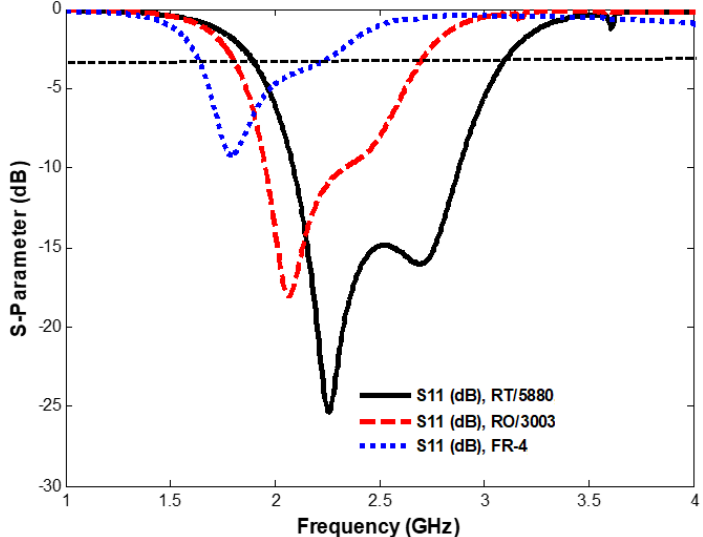
Figure 8. Comparison of S 11 for different dielectric substrate materials at h = 0.81 mm.